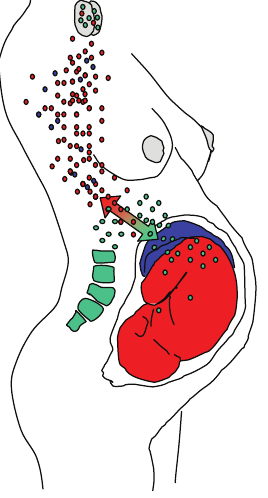
Figure 1: Pregnancy is the major source of natural microchim- erism. Pregnancy related microchimerism results from deficiencies in the natural placental physical barrier tissue that divide the maternal circulation from the fetal circulation. As a consequence, there is mutual and bidirectional maternal and fetal cell tra ffi c during pregnancy. Microchimeric cells enter the circulation and persist for many years in the host tissues. These cells are tolerated while acquire specific and diverse biological actions. (Copy of Figure5 in